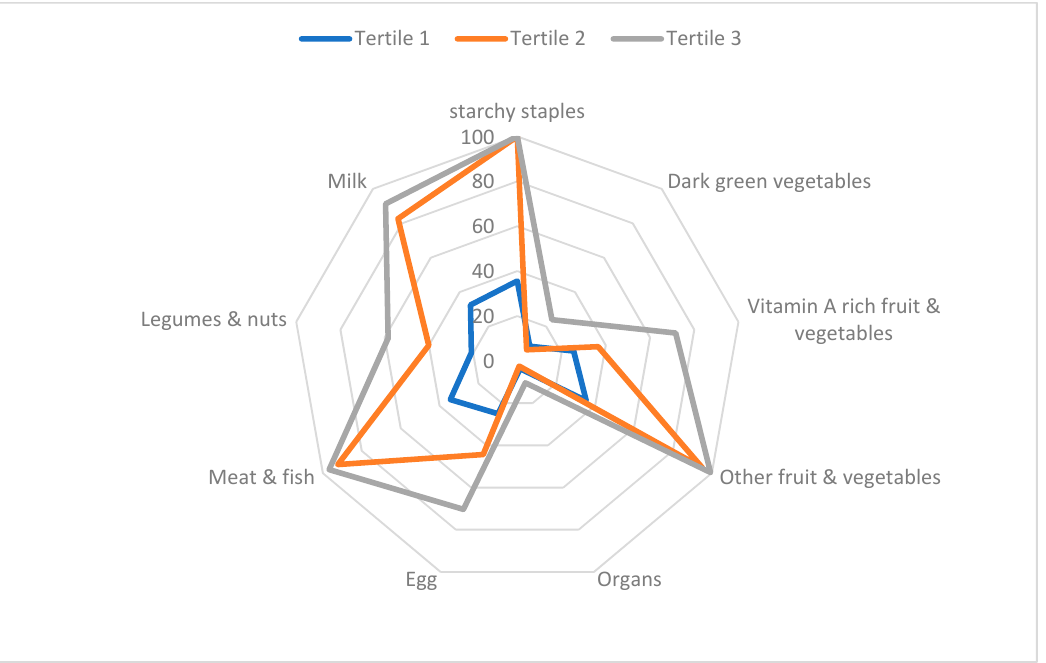
Figure 1. Frequency of consumption for the nine food groups that determinate diet diversity score according to tertile of scores.